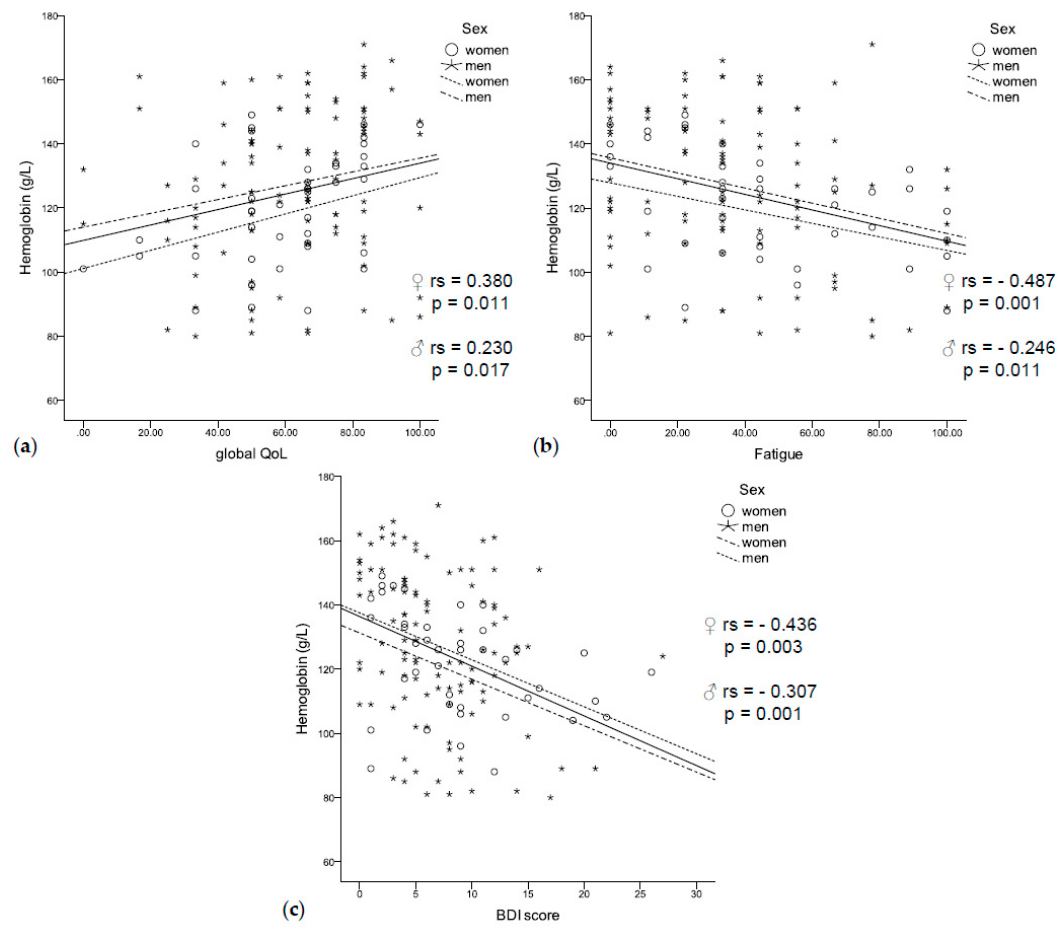
Figure 3. ( a ) Low hemoglobin concentrations were related to a worse quality of life, ( b ) fatigue, ( c ) and a higher BDI score independent of sex.